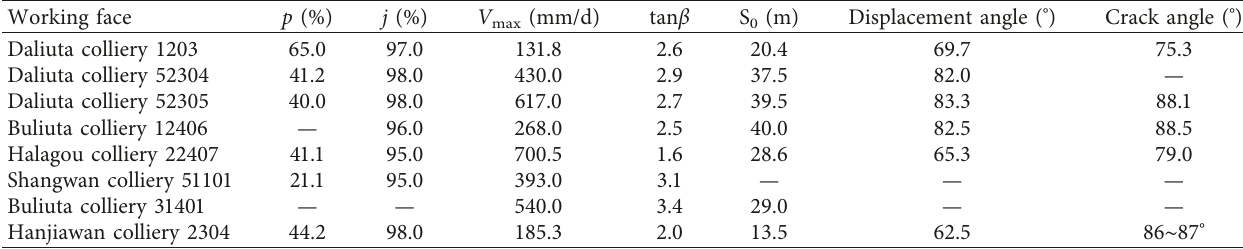
Table 2: Related surface subsidence parameters of some SLWF [28–34, 41]. Working